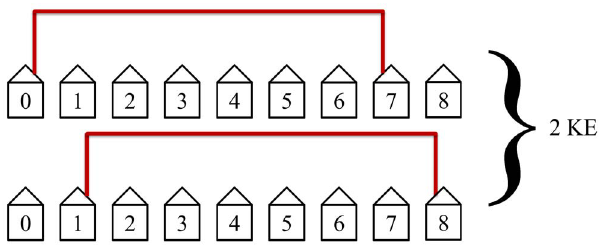
Figure 21. The last step in our example with N =8. This step is not efficient but only requires one KE since there is only one pair of hosts that are eight hosts apart.